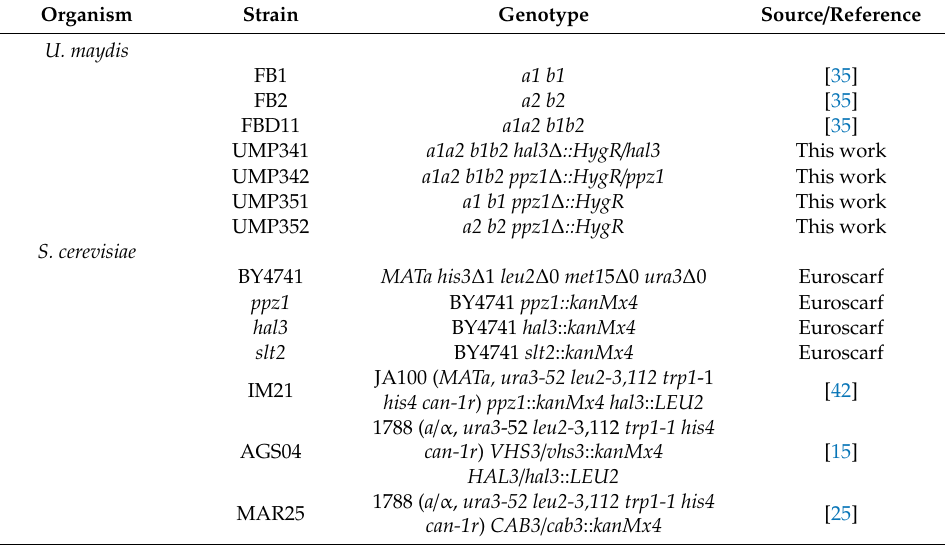
Table 1. List of fungal strains used in this work and their